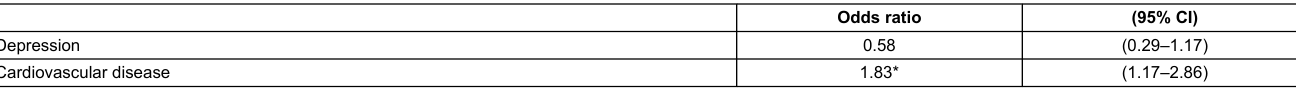
Table S4: Estimated independent associations of smoking cessation between SAPALDIA1 (1991) and SAPALDIA2 (2002) with different personal characteristics assessed at SAPALDIA1, without and with inverse probability weighting (IPW).